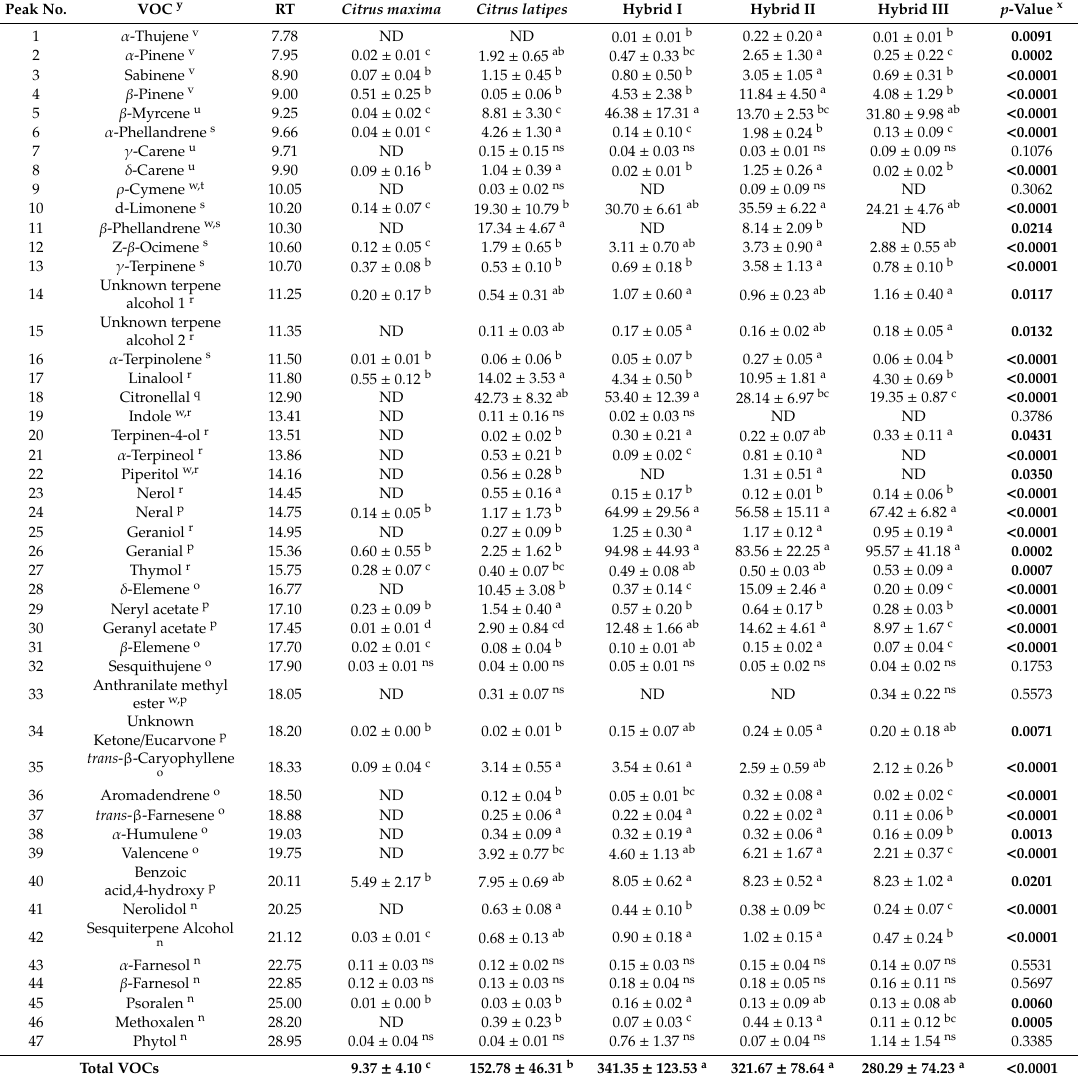
Table 2. Concentration ( µ g · g − 1 FW) of di ff erent hexane-extracted volatile organic compounds detected in leaves of C2-5-12 Pummelo ( Citrus maxima ), C. latipes and three corresponding sexual hybrids using gas chromatography-mass spectrometry ( n = 5) z